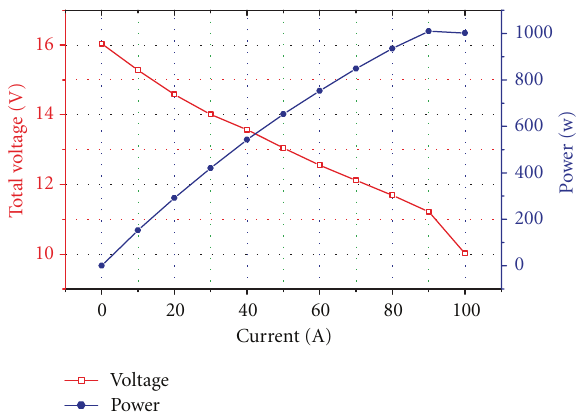
Figure 9: Performance of 20 cell fuel cell stack using the composite membrane.